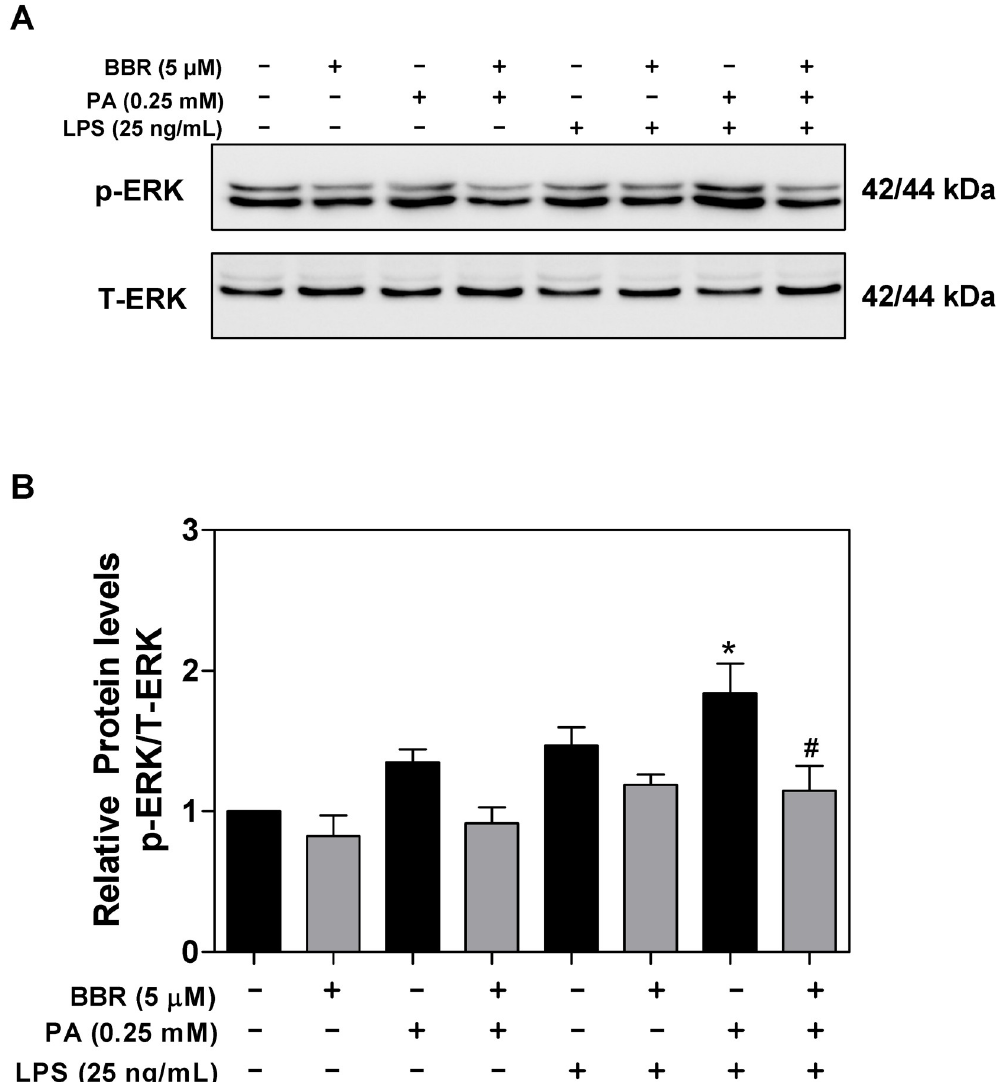
Fig 5. Effect of BBR on PA and LPS-induced ERK activation in RAW264.7 macrophages. RAW264.7 cells pre-treated with BBR (5 μ M) for 1 h, then treated with PA (0.25mM) or LPS (25 ng/mL) or both for 6 h. Total cell lysates were prepared for Western blot analysis as described under Materials and Methods. Values are mean ± S.E. of three independent experiments. Statistical significance relative to vehicle control, � p < 0.05, �� p < 0.01; relative to PA+LPS, # p < 0.05. A . Representative immunoblots of phospho(p)-ERK and total (T)-ERK; B . The relative protein levels of p-ERK.